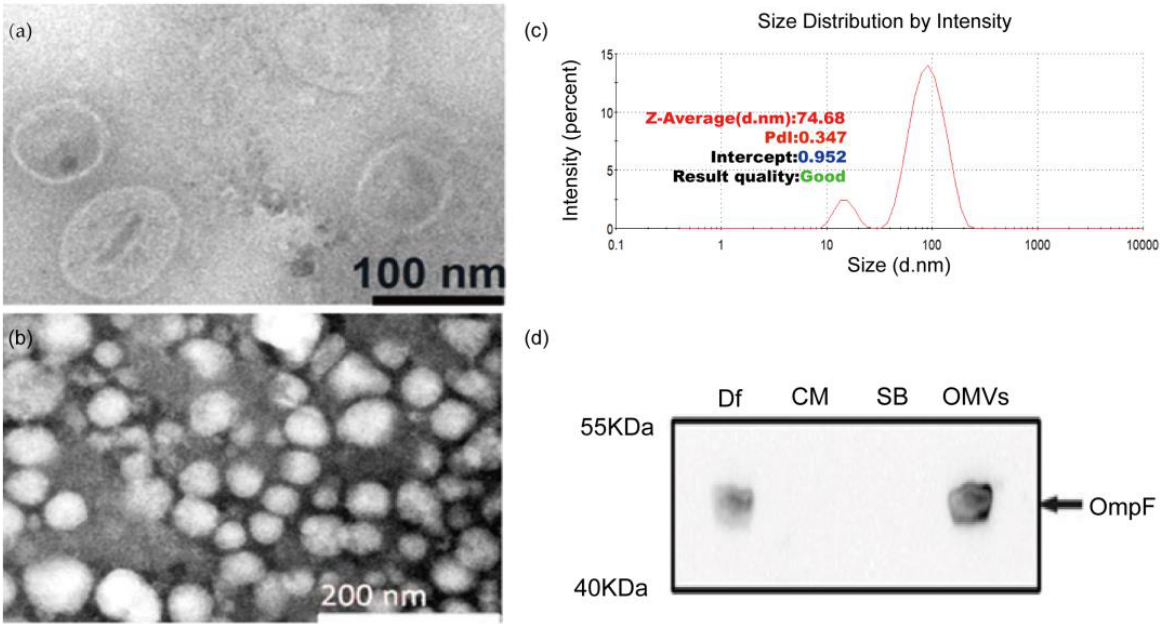
Figure 1. Morphology and membrane protein characterization of OMVs from D. fairfieldensis . ( a , b ) Negative-staining transmission electron microscopy of OMVs purified from D. fairfieldensis . ( c ) Na- noparticle-tracking analysis of OMVs was determined by Malvern particle size analyzer ZEN3700. ( d ) Western blot of specific OMV markers. Df: the abbreviation of D. fairfieldensis ; CM: bacterial culture medium; SB: OMVs storage solution; OMVs: outer membrane vesicles.